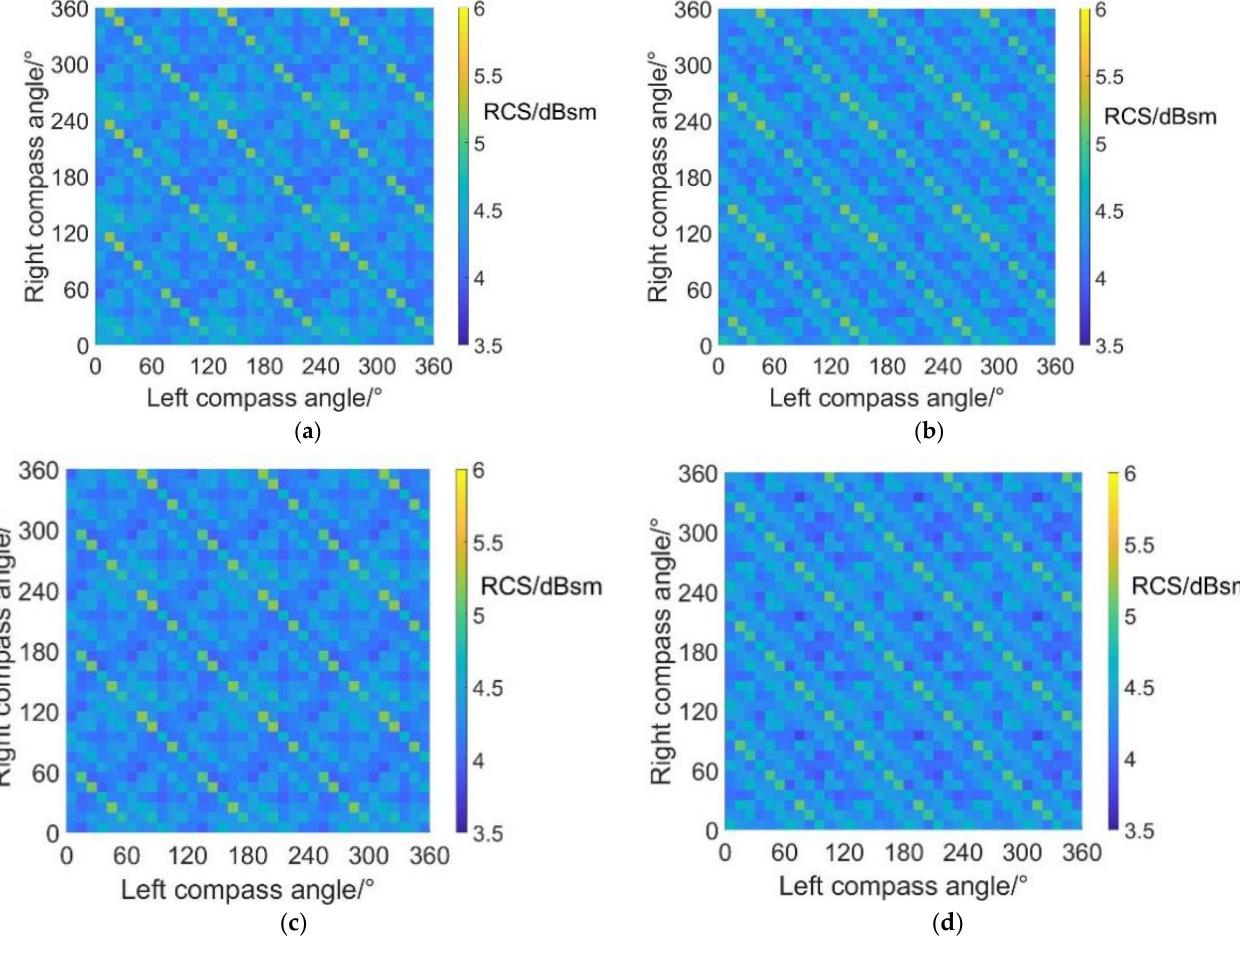
Figure 18. Carpet diagrams of average RCS in helicopter mode at an azimuth angle = 180° with scissors angle difference = ( a ) 0°, ( b ) 30°, ( c ) 60°, ( d ) 90°.